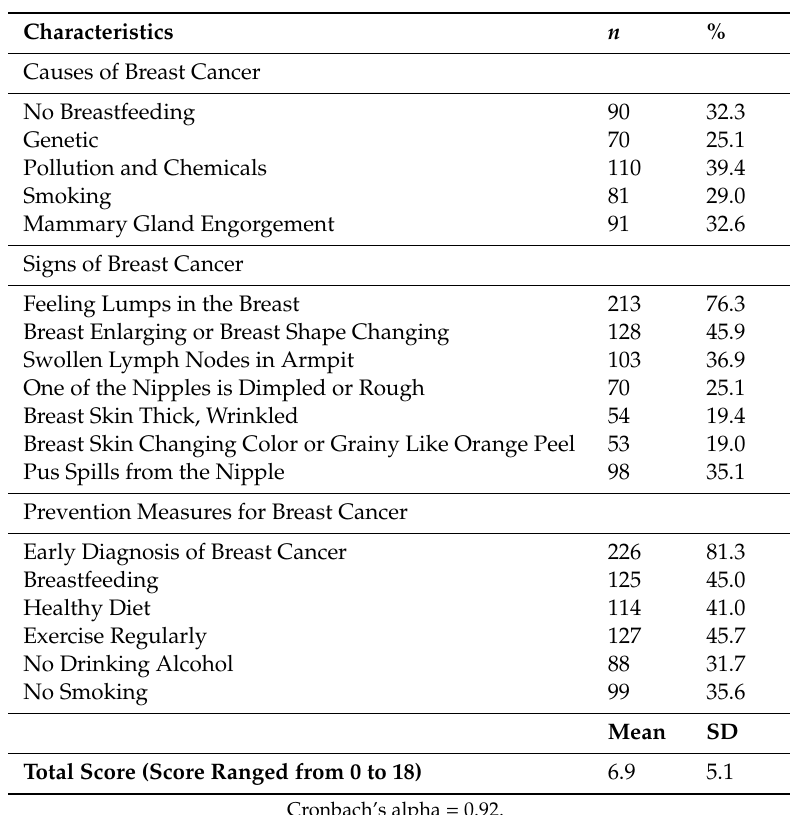
Table 3. Knowledge of breast